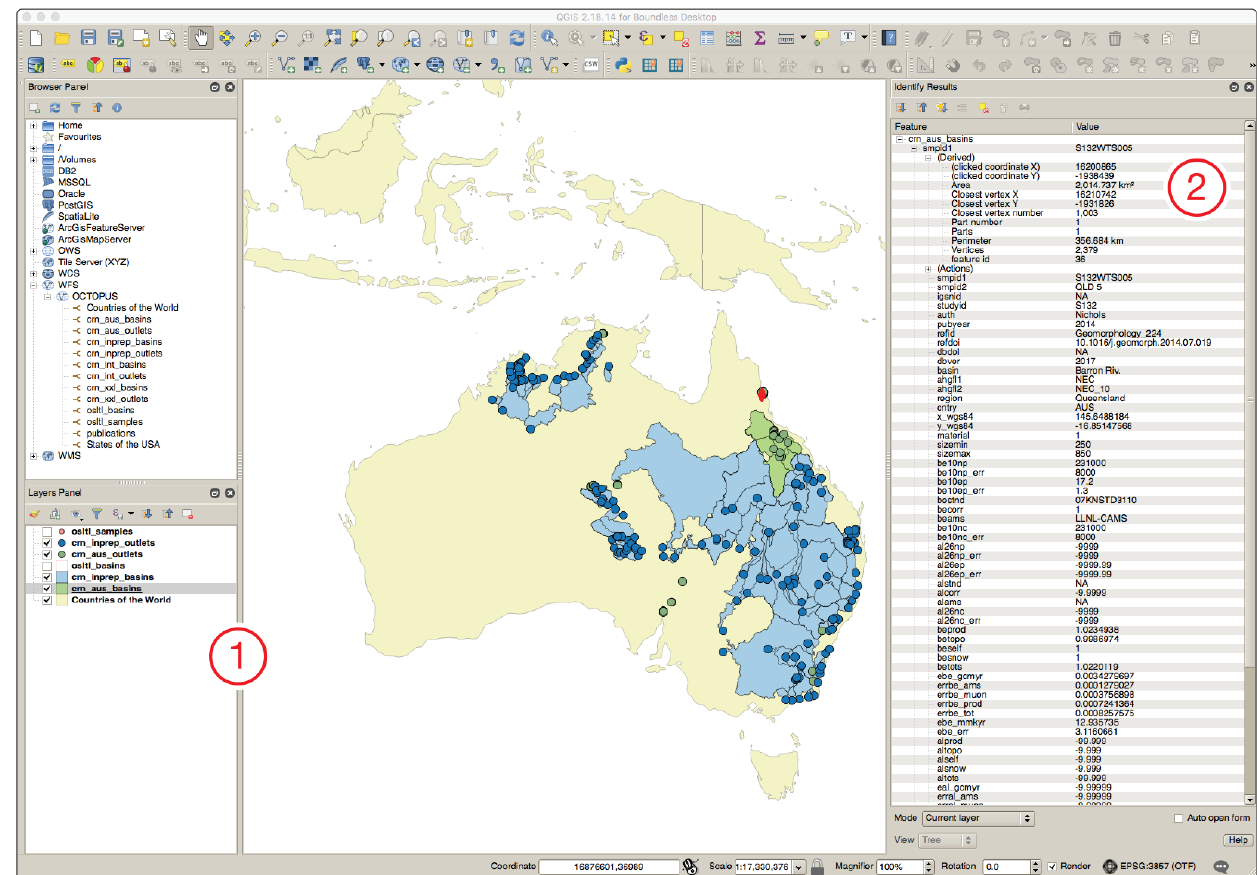
Figure 4. Screenshot of the QGIS application interface displaying data from OCTOPUS accessed through a WFS connection. A WFS connection will provide direct access to the data, meaning that (1) its symbology can be modified, (2) it can be queried, and analysis functions can be run on